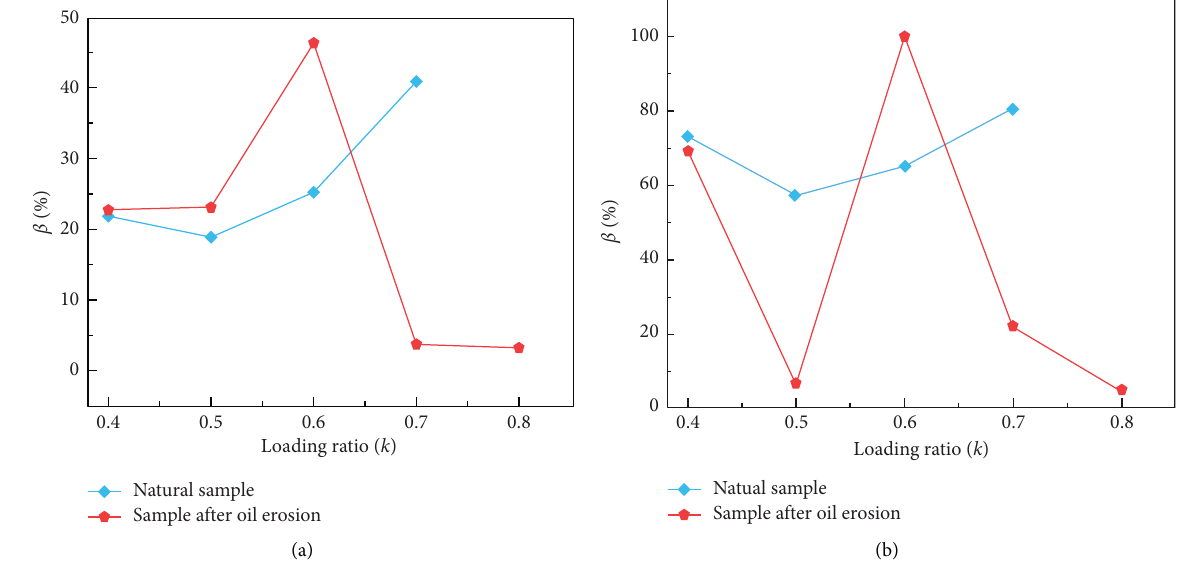
Figure 8: Relationship between β and the stress level ( k ).